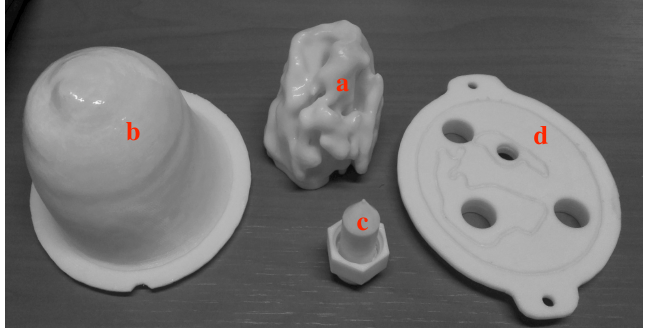
Figure 2. The different parts of the GeePs-L2S breast phantom: ( a ) The inner part contains the fibroglandular or heterogeneous mix tissue mimicking material (TMM); ( b ) the outer shell contains the fatty TMM; ( c ) the removable inclusion contains the tumor-like TMM; and ( d ) the support plate holds the different parts in